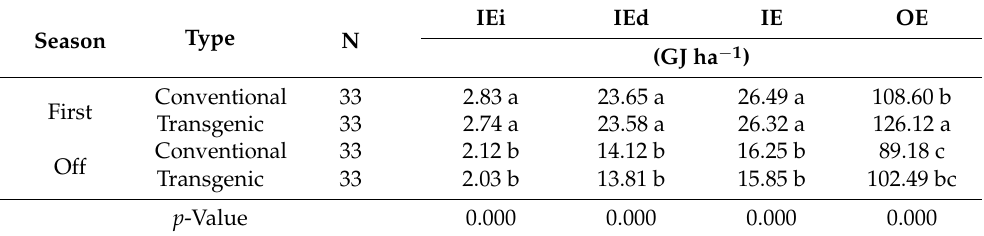
Table 2. Comparison of inputs and outputs of first and second crop corn, conventional and transgenic. Season